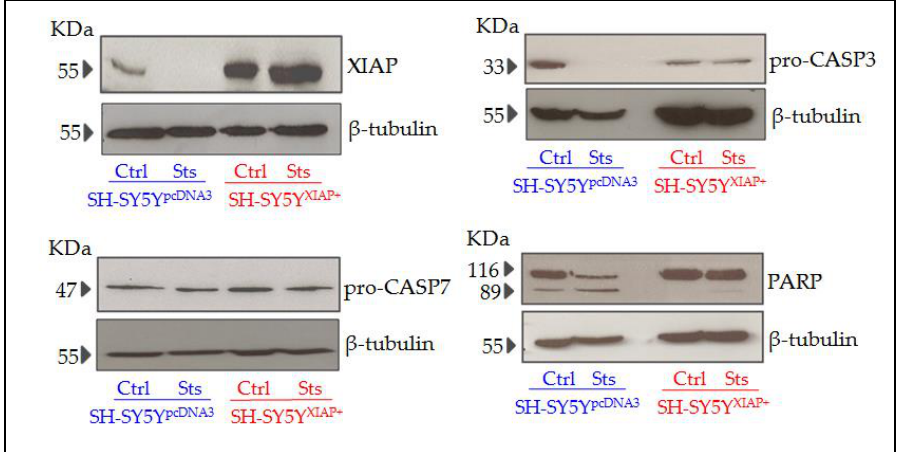
Figure 7. Expression levels of different apoptotic-related proteins in SH-SY5Y cells after Sts treatment. Representative immunoblots of XIAP, pro-CASP3, PARP, and pro-CASP7 and loading control β -tubulin proteins expression in SH-SY5Y pcDNA3 and SH-SY5Y XIAP+ cell line lysates before and after treatment with Sts (25 nM for 24h).